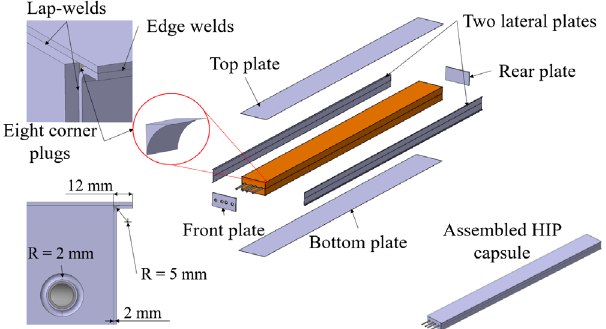
FIG. 3. HIP capsule components and main characteristics.